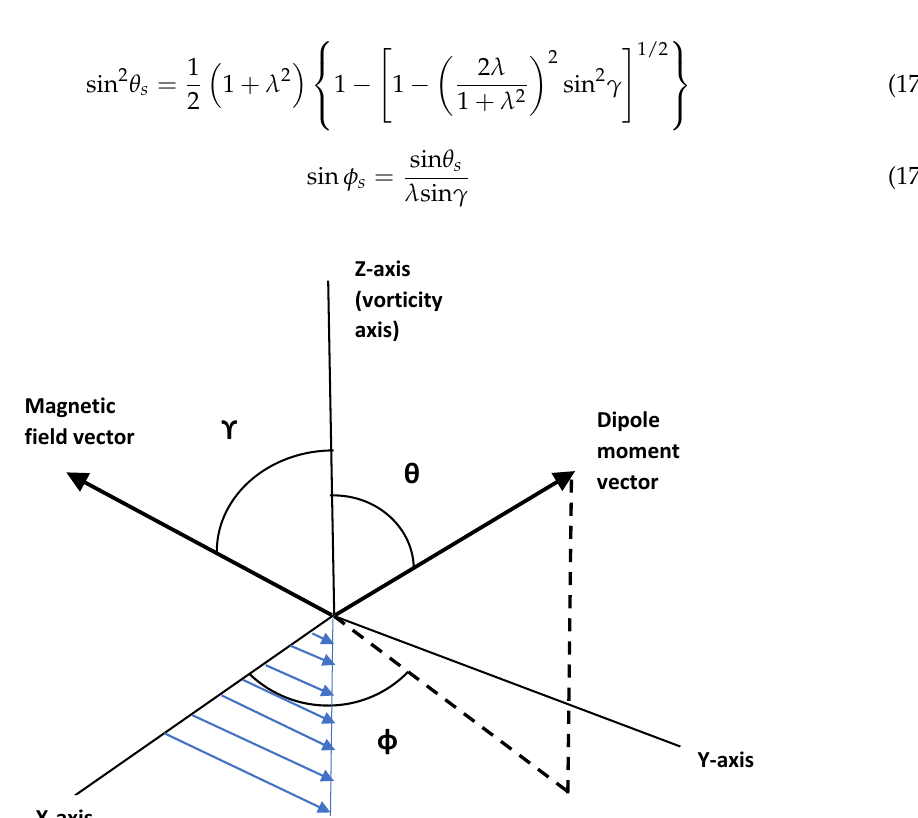
Figure 25. Coordinate system. The magnetic field is assumed to be in X-Z plane with azimuthal angle of zero degree.